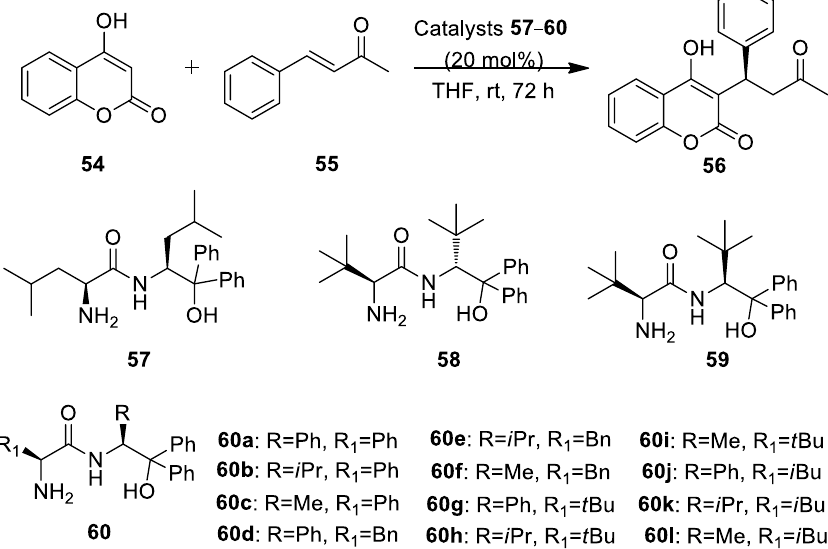
Scheme 22. Asymmetric synthesis of warfarin using amino amides as chiral templates.